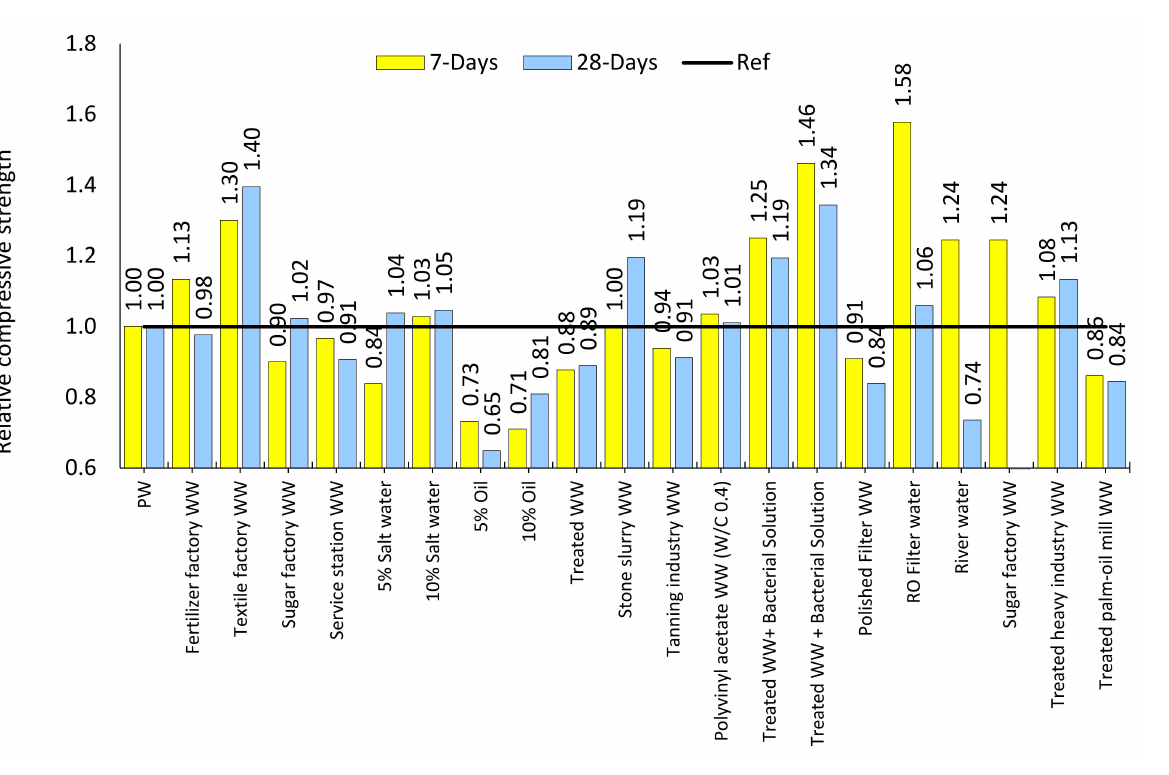
Figure 9. Compressive strength of different WW concrete relative to that of tap water or potable water